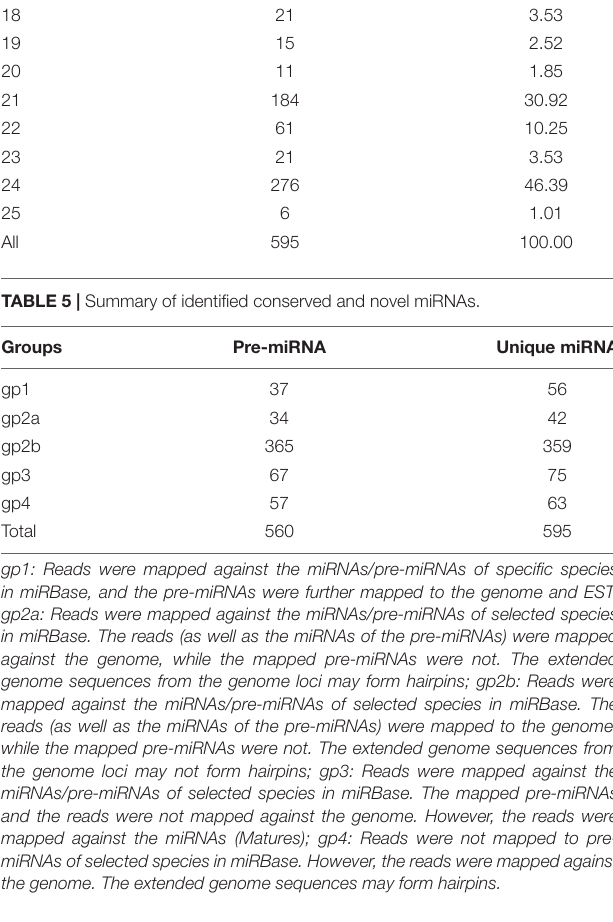
same respective conditions. Moreover, 12 miRNAs, such as mtr-